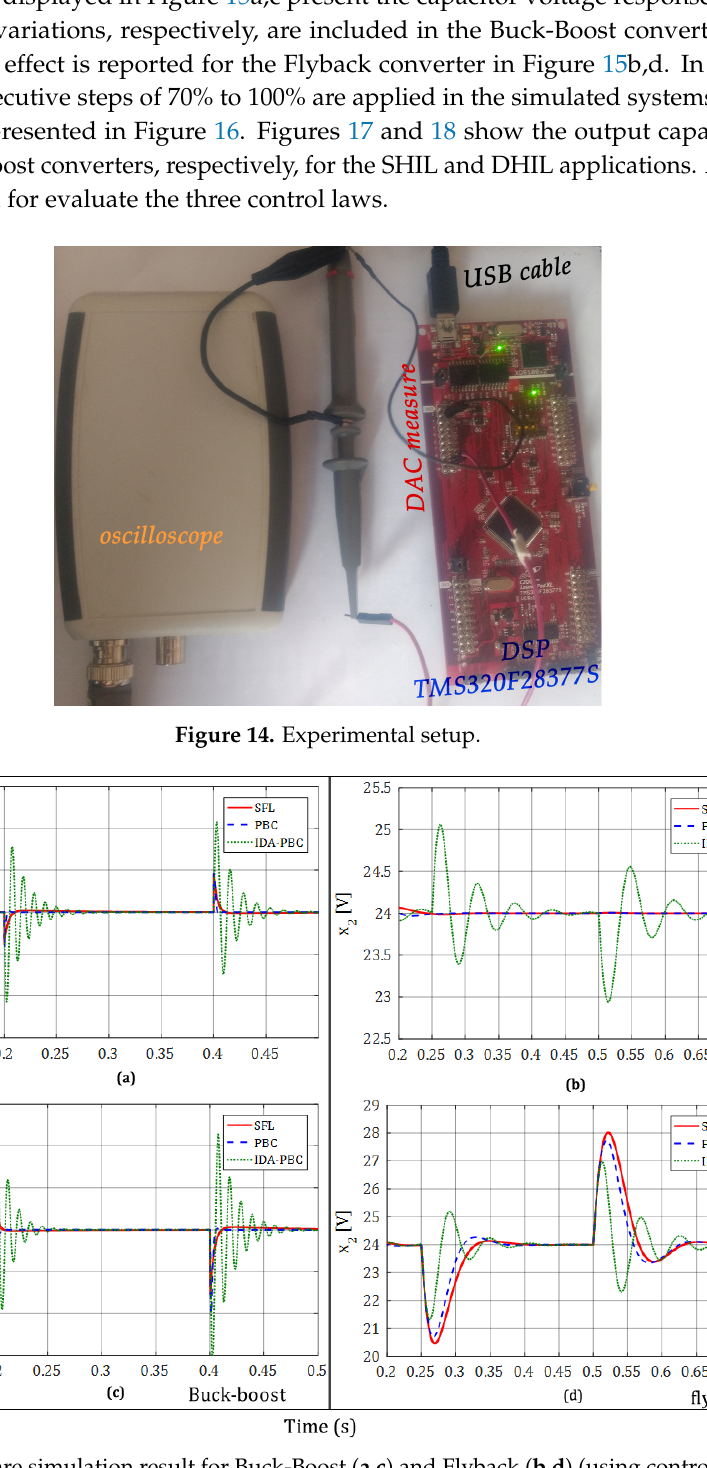
Figure 15. Software simulation result for Buck-Boost ( a , c ) and Flyback ( b , d ) (using control techniques SFL (red), PBC (blue) and IDA-PBC (green). Output voltage x 2 for input voltage ( a , b ) and for load variation ( c , d